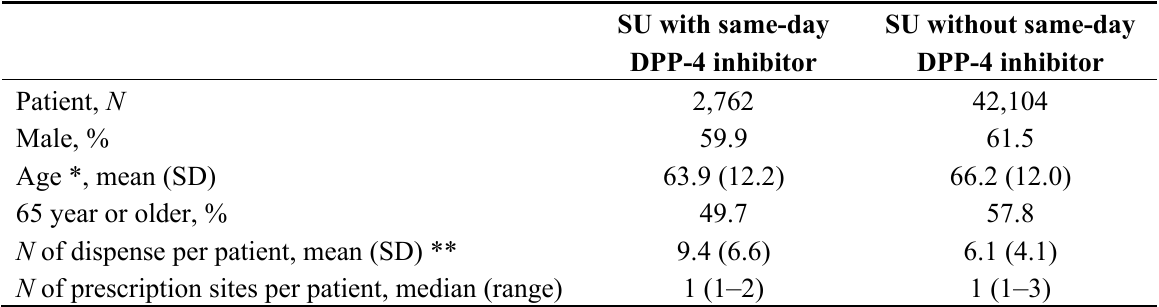
Table 1. Characteristics of sulfonylureas (SU) users with or without same-day dipeptidyl peptidase-4 (DPP-4)